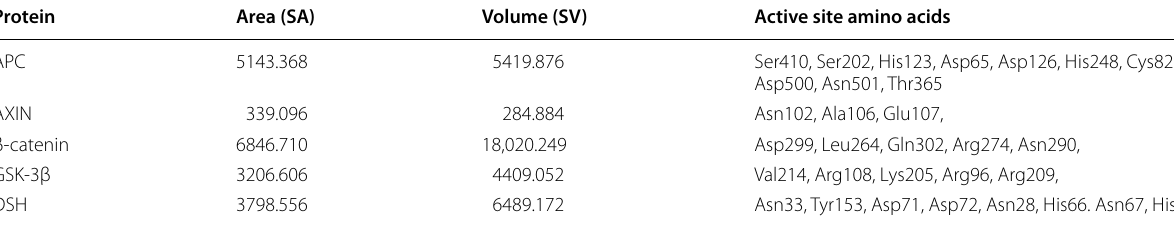
Ares (SA), surface area; Volume (SA), SURFACE VOLUME